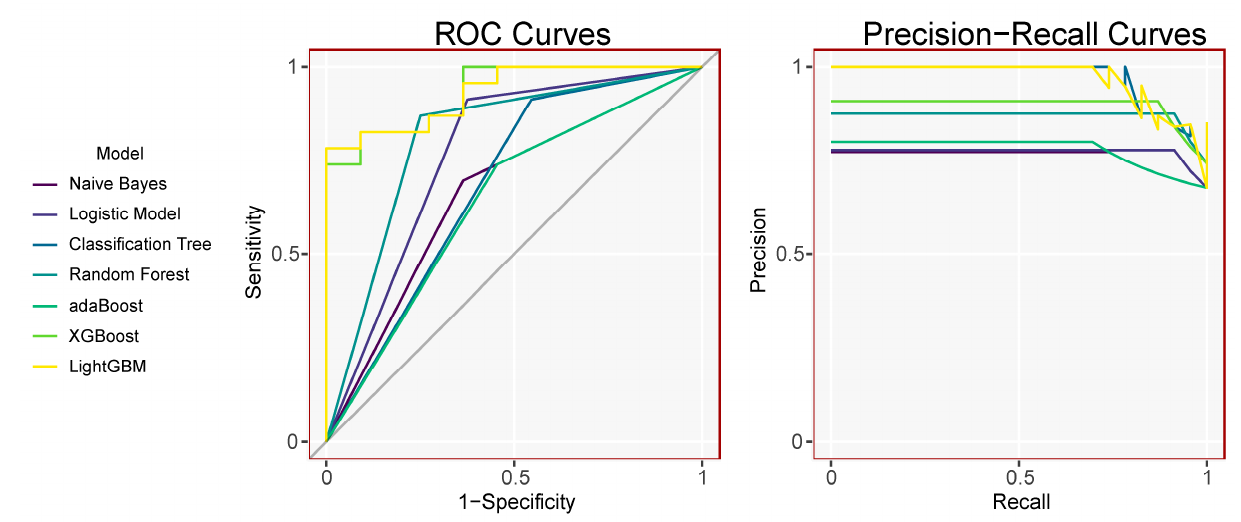
Figure 1. Receiver operating characteristic curves and precision-recall curves of the seven different machine learning models.